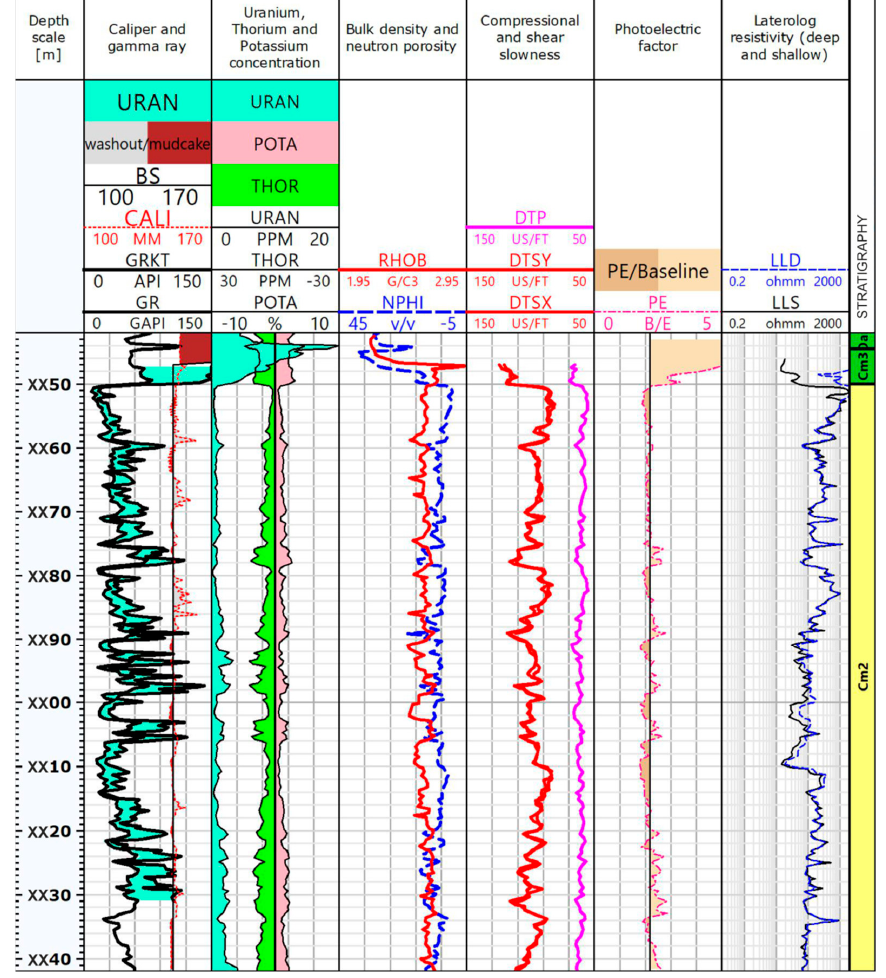
Figure 3. The dataset with available well ‐ log data from well W ‐ 2. Effective porosity was derived from the neutron–density cross ‐ plot method and calibrated with core porosity measured with the use of the mercury porosimetry method [26]. In this method by forced injection of mercury into the pore space of the tested ma ‐ terial, it is possible to calculate the critical diameter of the capillary into which mercury can penetrate under a given injection pressure, as well as other parameters characteriz ‐ ing the pore space, e.g., effective porosity and bulk density. TOC content in the Cm2pp interval was obtained from the correlation between uranium concertation and TOC content from laboratory Rock ‐ Eval measurements [26]. The TOC is measured during Rock ‐ Eval Pyrolysis, during which the organic content in the rock sample is decomposed in oxygen absence, followed by combustion. The quan ‐ tity of hydrocarbons and carbon dioxide released during this process allow for the de ‐ termination of the richness and maturity of potential source rocks. The water saturation of tight sandstone layers was calculated from well logs with the use of Archie equation. Full ‐ wave sonic waveforms acquired by the Halliburton Wave Sonic Tool enabled the calculation of the rocks’ dynamic elastic properties. Full ‐ wave acoustic logging is a new ‐ generation tool that enables a better understanding of the wave propagation around a borehole. The acoustic wavetrain is composed of compressional, shear, and Stoneley waves. Table 1 presents the results of laboratory rock mechanical tests carried out on a